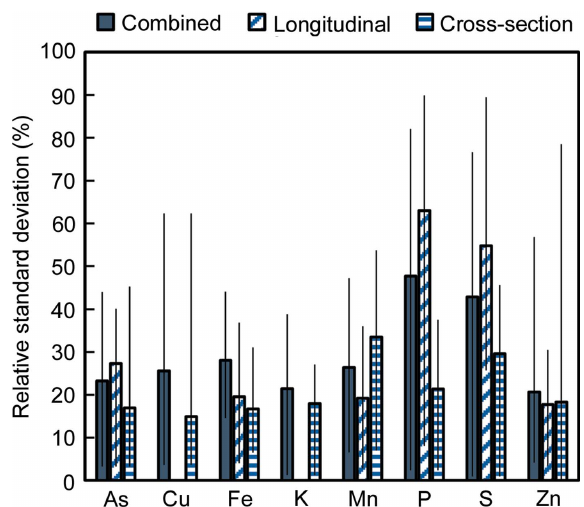
Figure 2 Reproducibility of SR- m XRF measurements of replicate sample scans for grains sectioned longitudinally, cross-sectionally or combining the two sectioning types. The combined values include replicates across and within section types. Note that replicate scans have biological variability as each scan is from a different grain from an individual plant. Error bars denote the maximum and minimum values measured ( n = 12 for combined, n = 8 for longitudinal and cross-section). Missing bars indicate that no data were